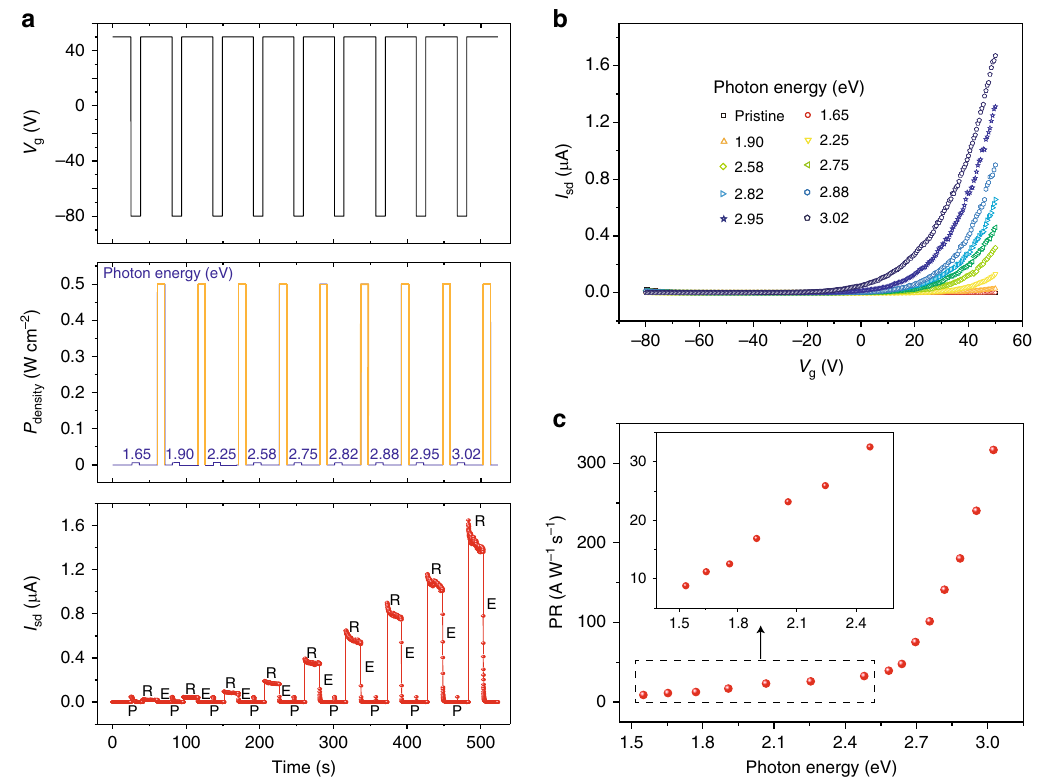
Fig. 4 Wavelength distinguishing ability of WSe 2 /BN optoelectronic memory. a Dynamic behavior of the WSe 2 /BN memory illuminated by a wide spectrum of lights with wavelength ranging from 750 to 410 nm. Nine distinguishable storage states are clearly observed under different programming wavelengths. b The corresponding transfer characteristic with respect to wavelength after each programming. c Programming rate as a function of photon energy. Inset: plot of the enlargement from 1.55 to 2.48